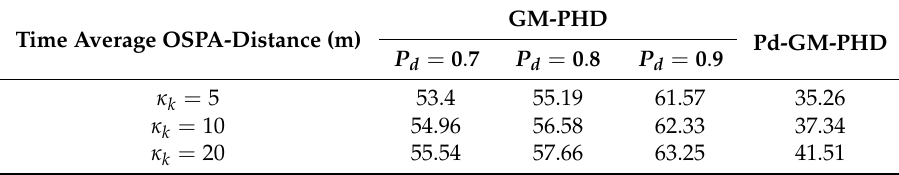
Table 2. Comparison of time average Optimal Subpattern Assignment distance (OSPA-distance, m) in different clutter environment. GM-PHD: Gaussian Mixture Probability Hypothesis Density.